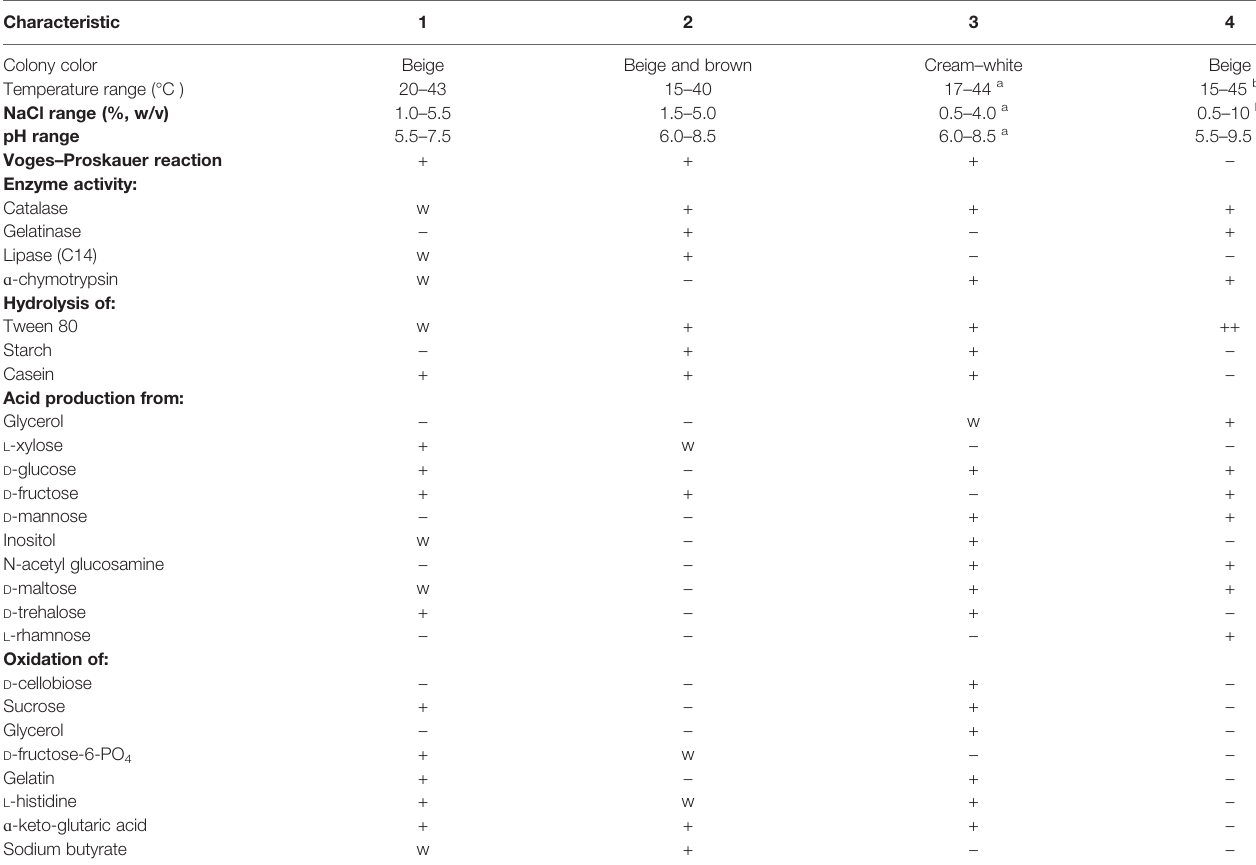
TABLE 1 | Differential characteristics between strains A6E486 T and 5E331 T and experiment control strains. Characteristic 1 Colony